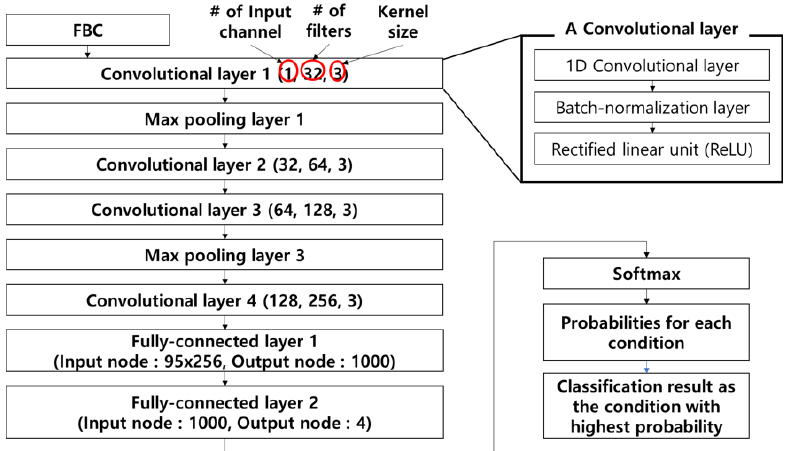
Figure 5. Convolutional neural network (CNN) structure for bearing fault diagnosis.